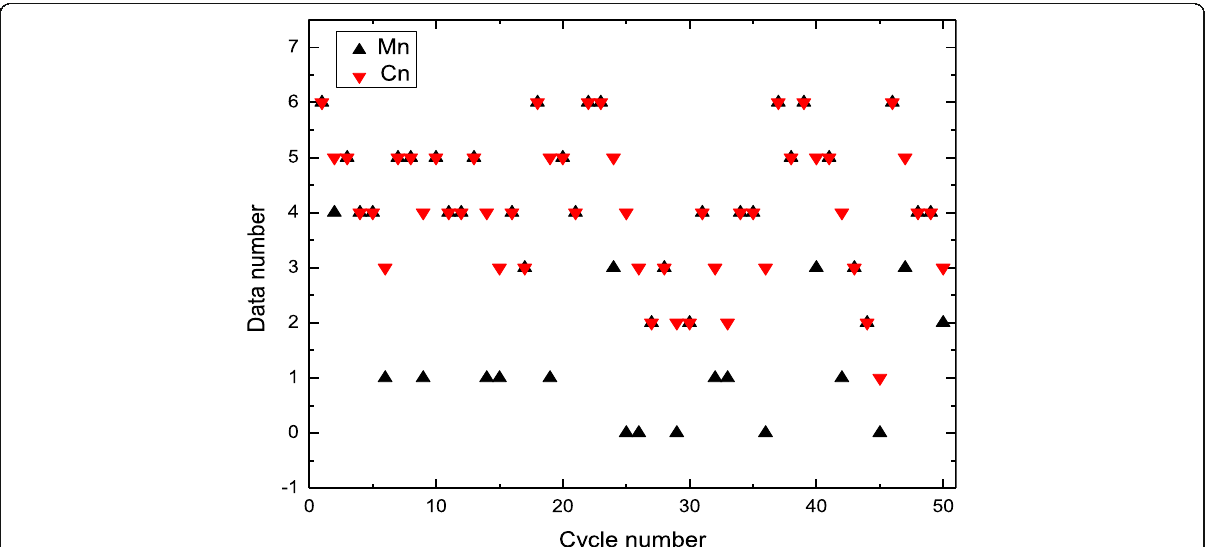
Fig. 34 The total volume of data randomly changes from 0 to 6; Mn and Cn inthe first 50